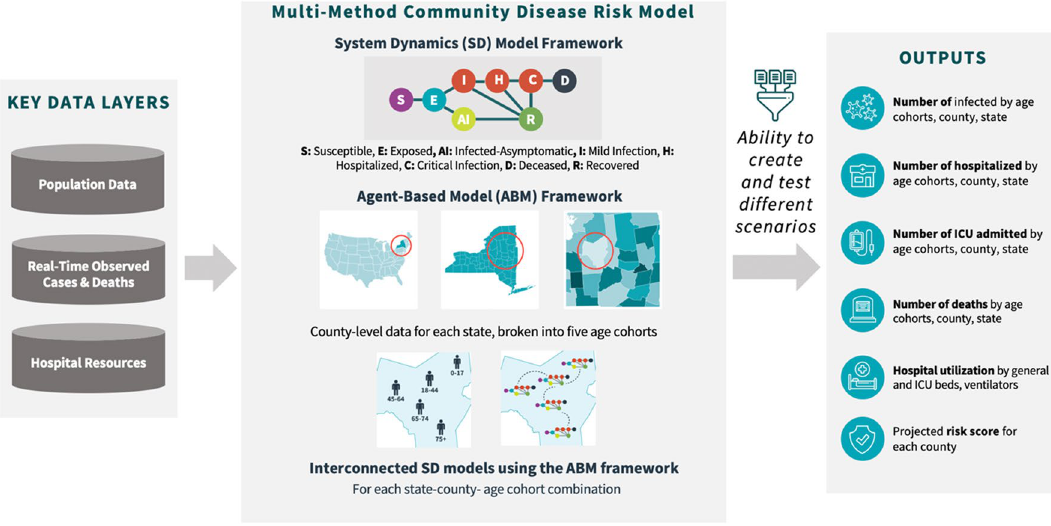
Figure 1. Overview of the multi-method community disease risk model (M 2 -CDRM) including key data layers, modeling framework, and model